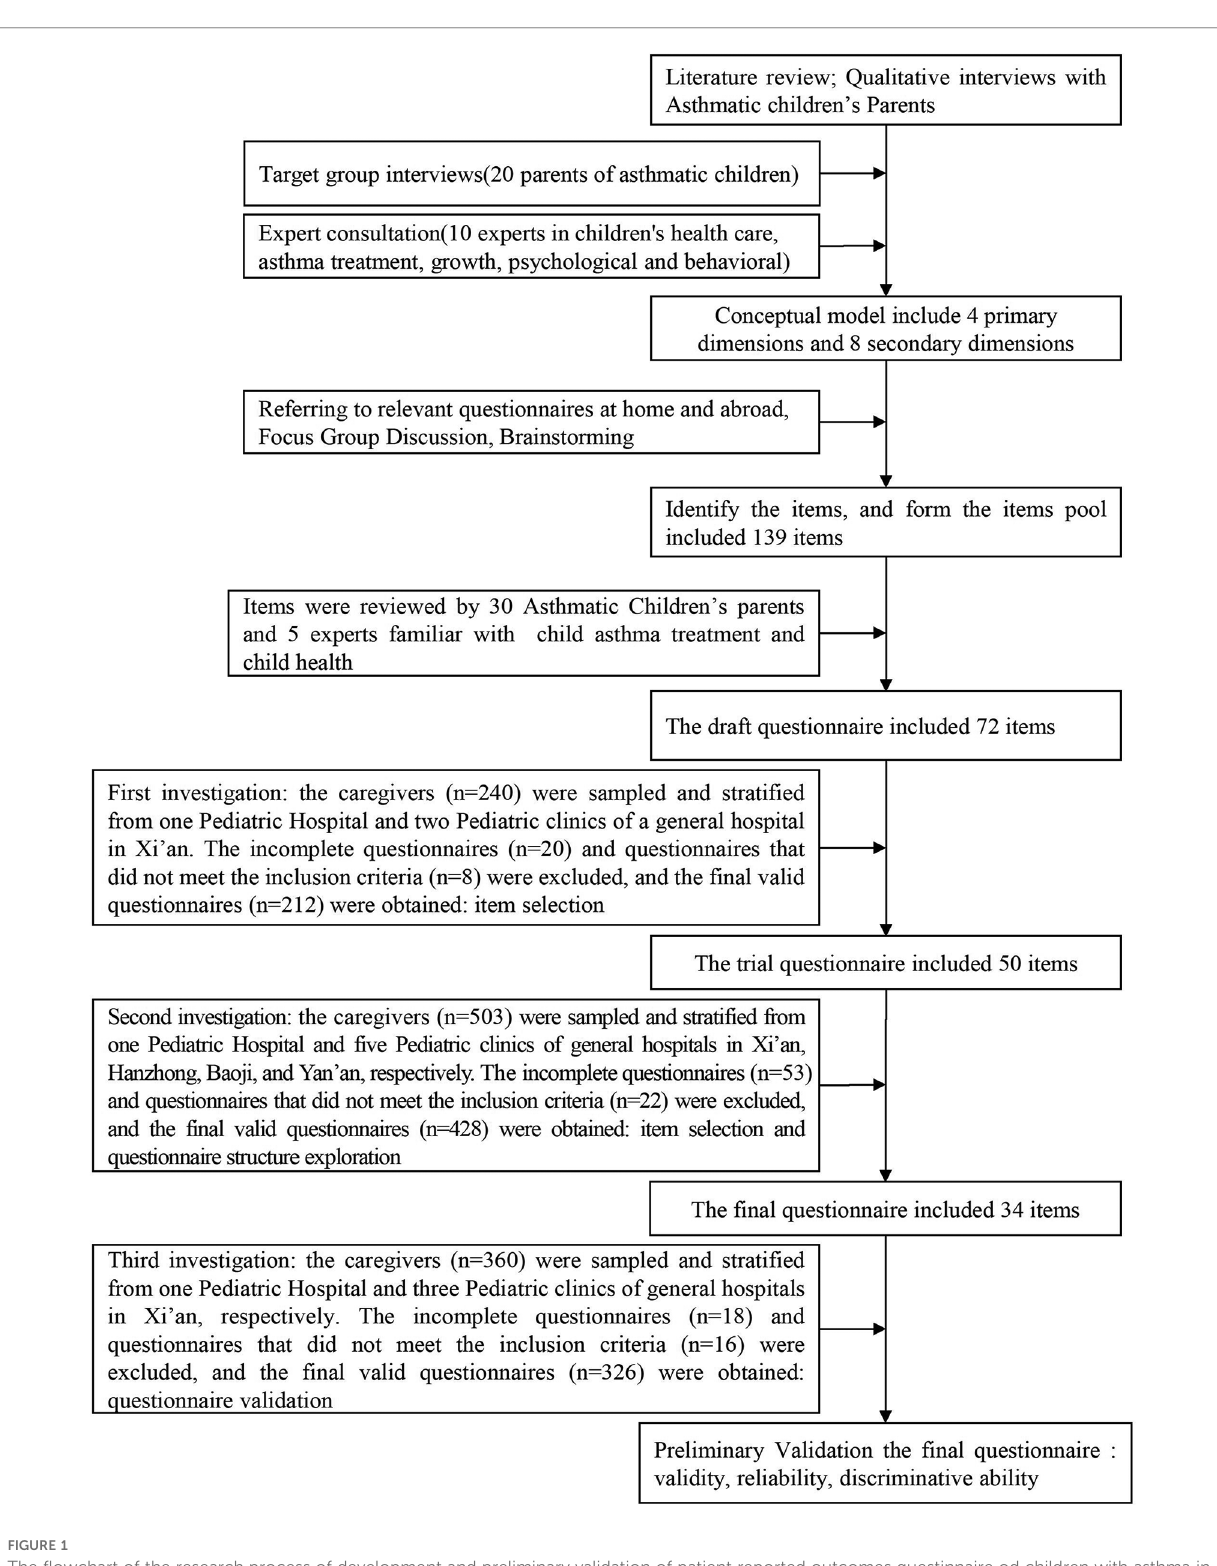
FIGURE 1 The fl owchart of the research process of development and preliminary validation of patient reported outcomes questinnaire od children with asthma in China: A caregiver ’ s proxy-reported